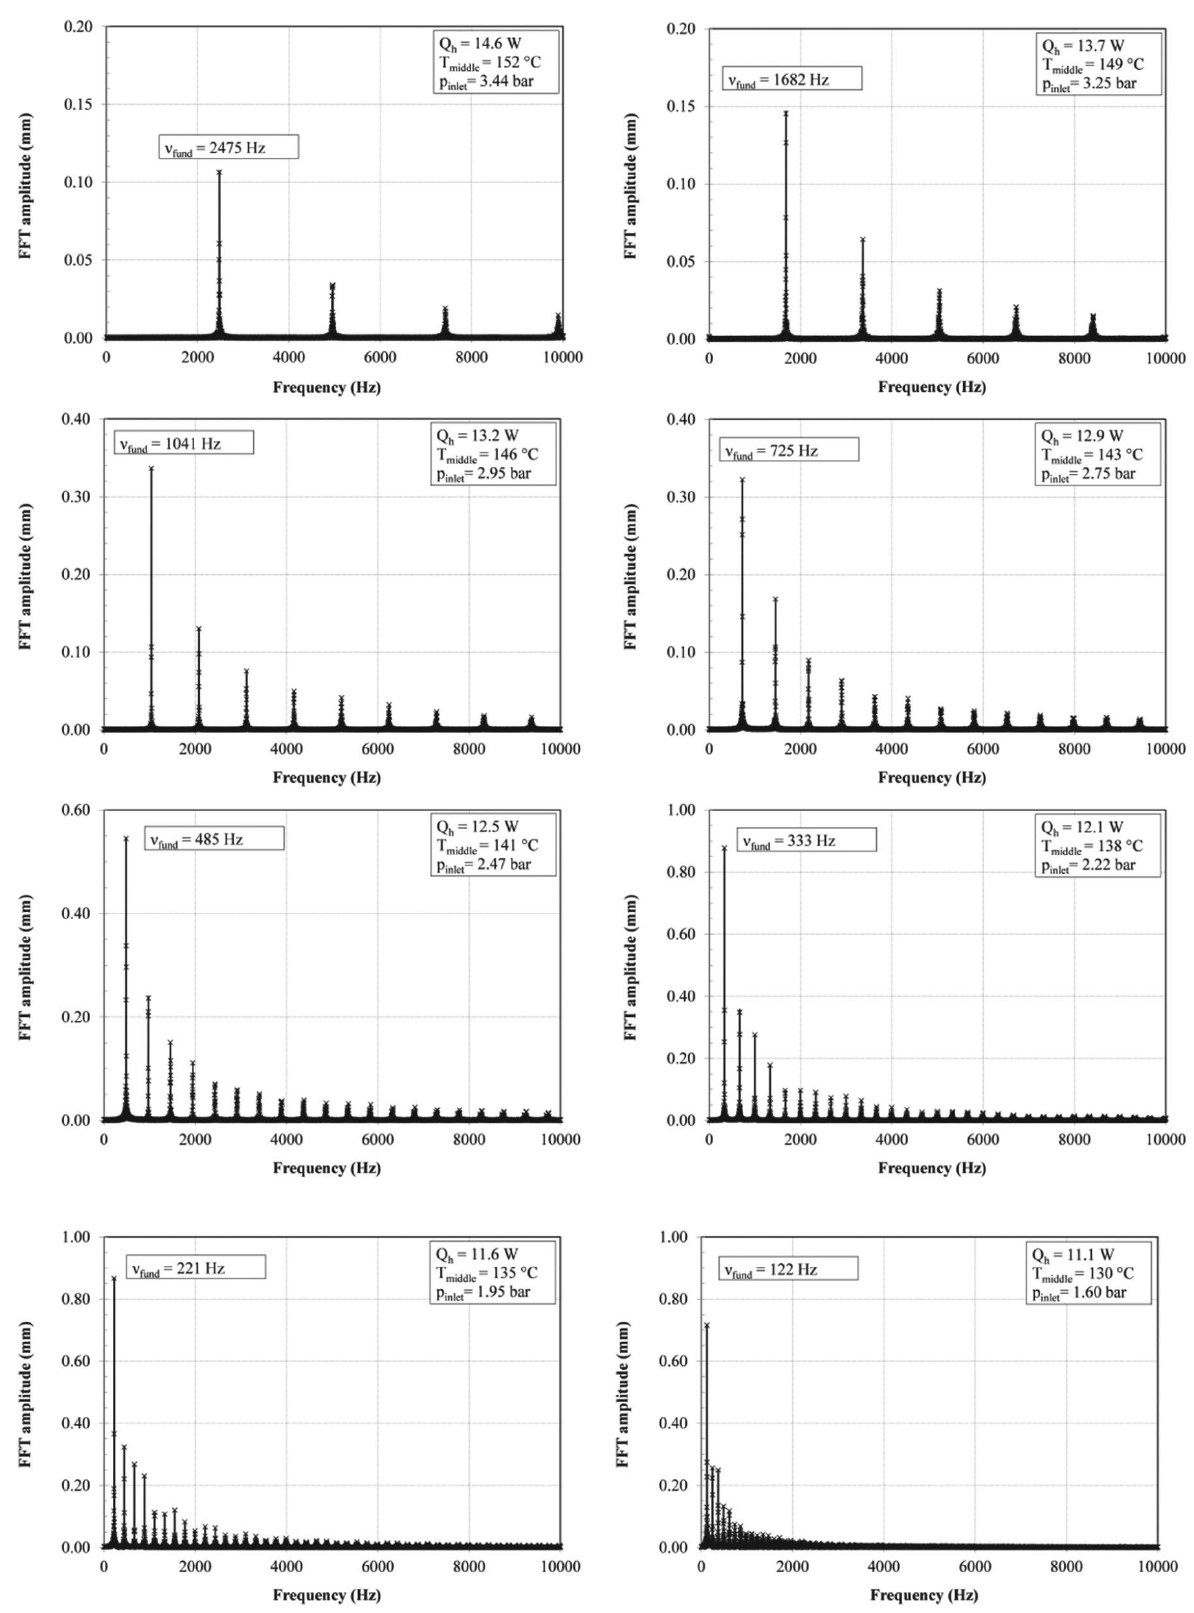
Figure 8. FFT analysis of meniscus oscillations during boiling in a single 50 × 50 µm microchannel at temperatures ranging from 152 °C to 130 °C in the middle of the